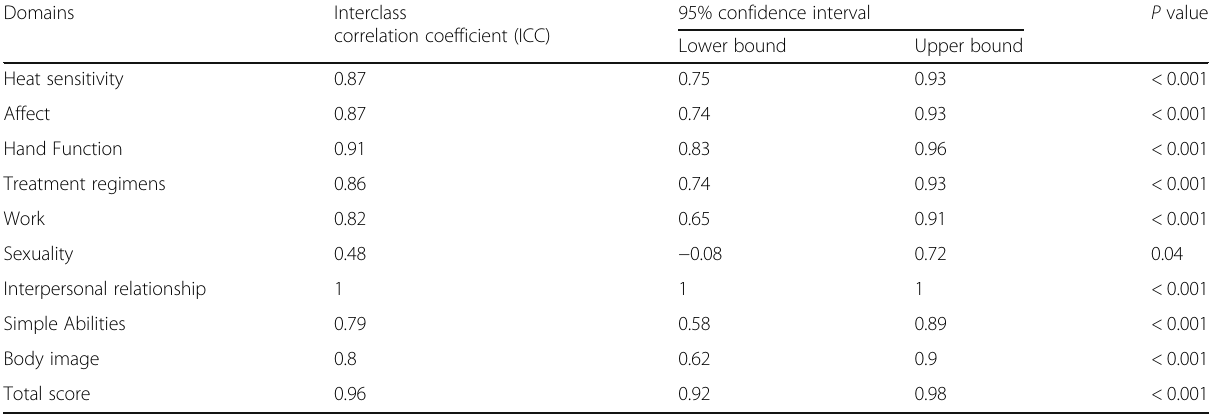
Table 3 Test re-test reliability of BSHS-B- Np